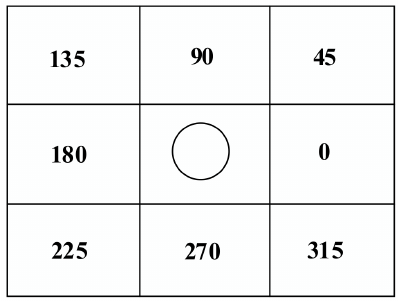
Figure 6. Angle of steering cost model of expansion node.